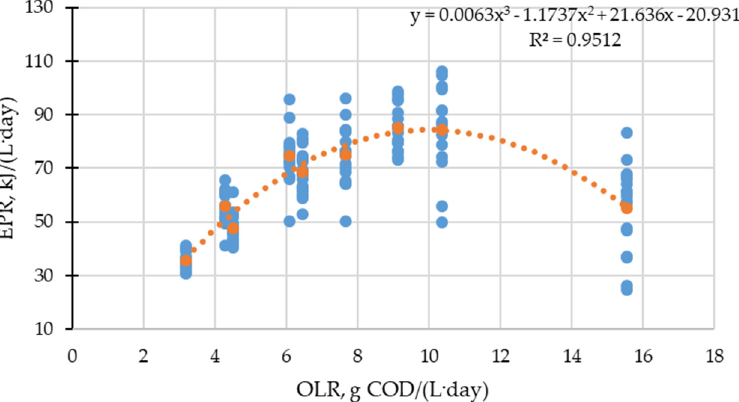
Figure 5. Dependence of EPR on OLR: blue—experimental data for semicontinuous two-stage digestion; orange—mean values and model.